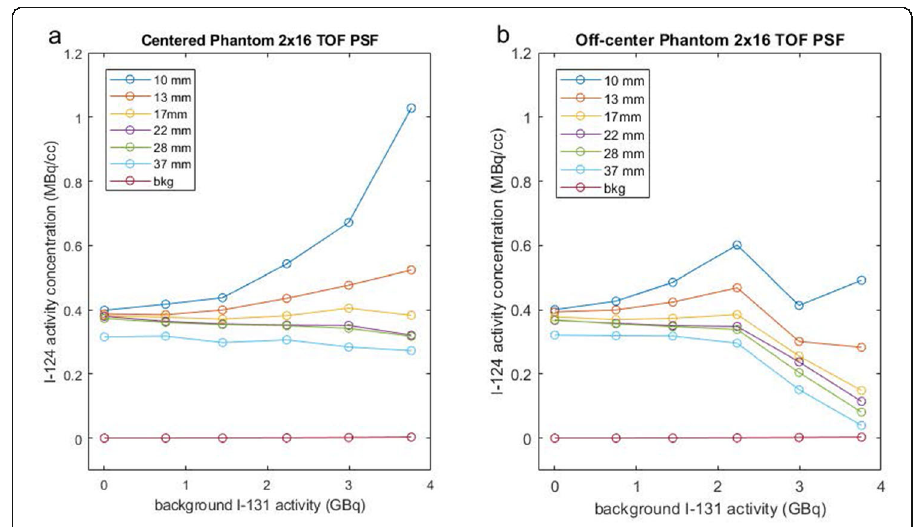
Fig. 1 124 I activity concentration in the phantom ’ s spheres as a function of increasing 131 I activity in the background measured on the PET image reconstructed with the OSEM algorithm with 2 iterations and 16 subsets, TOF information and PSF modeling. The phantom was placed in the middle of the field of view ( a ) and on the scanner table at the anterior most position, 11.2 cm higher (off-center) ( b